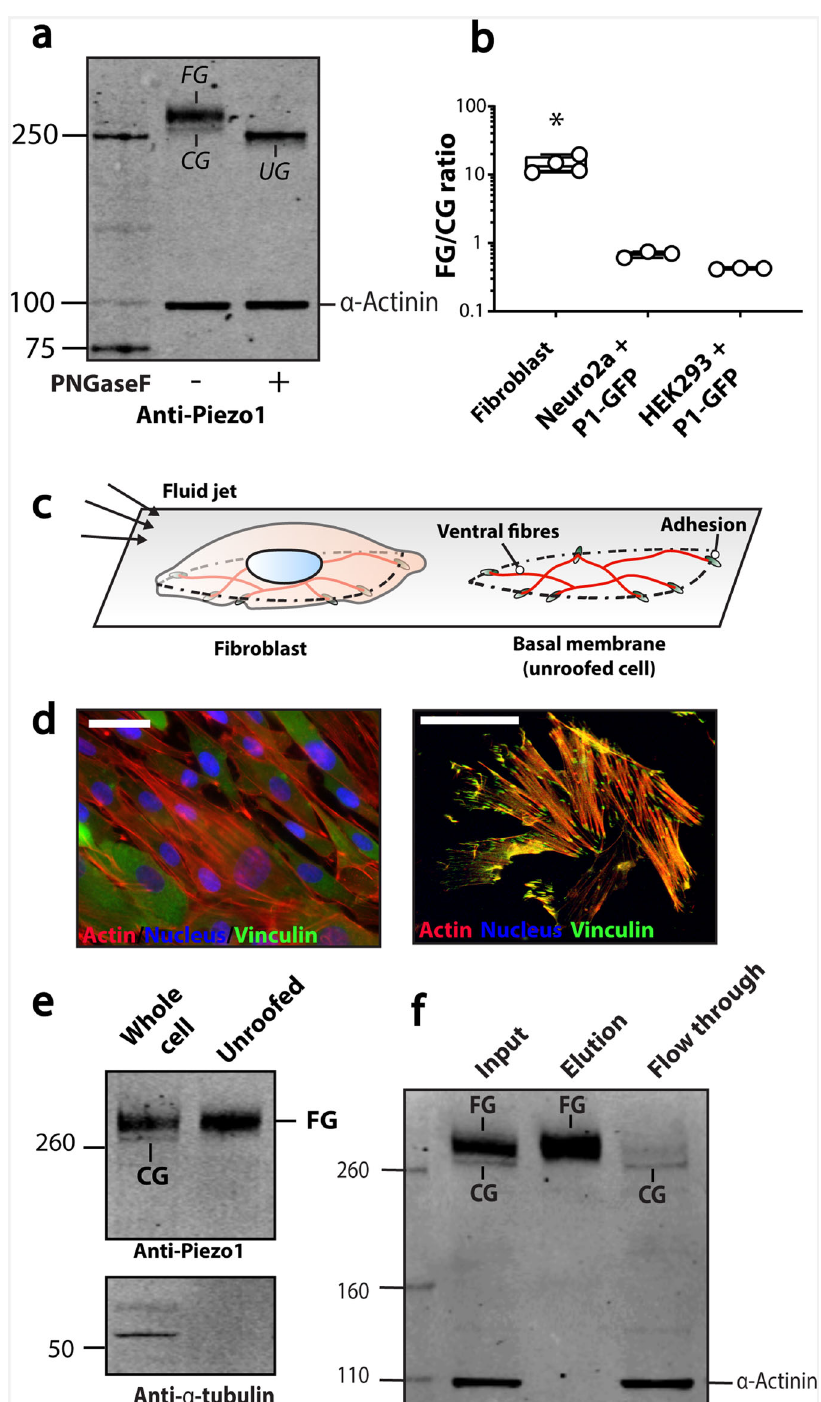
Fig. 2 N-glycosylation of endogenous Piezo1 in human fi broblasts. a A representative western blot of untreated immortalised human foreskin fi broblasts versus PNGaseF treated fi broblast lysate probed using the anti-Piezo1 antibody and anti- α -actinin antibody as a loading control. b The ratio [FG/CG] of the upper band (FG) and lower band (CG) of fi broblast Piezo1 and Piezo1 heterologously expressed in Neuro2A and HEK293T. c Schematic illustration of an intact fi broblast, and an unroofed fi broblast. d A representative image of an intact fi broblast (left panel), and an unroofed fi broblast (right panel) using standard wide- fi eld microscopy and a 63× oil objective. e A representative western blot of intact fi broblast lysate versus unroofed fi broblast lysate probed using anti-Piezo1 antibody and anti- α -tubulin antibody as a loading control to con fi rm unroo fi ng. f A representative western blot of biotinylated immortalised human foreskin fi broblasts. (CG core-glycosylated, FG fully glycosylated) * p < 0.05 determined by Kruskal – Wallis test with Dunn ’ s post- hoc test.